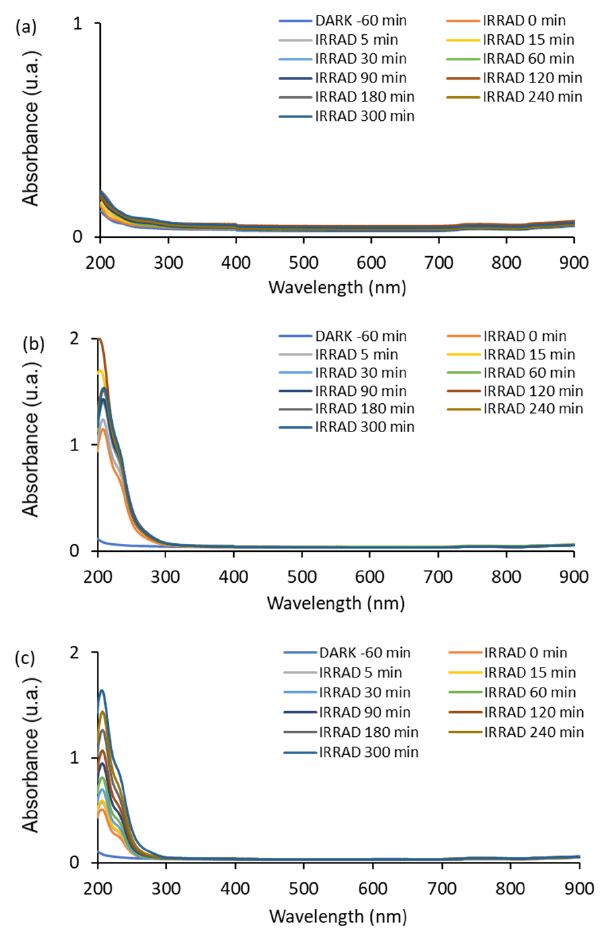
Figure 9. Leaching of the precursor catalysts detected from the UV–VIS spectra as a function of irradiation time: ( a ) Cu4; ( b ) Mo4; ( c ) Cu4Mo4 catalysts.